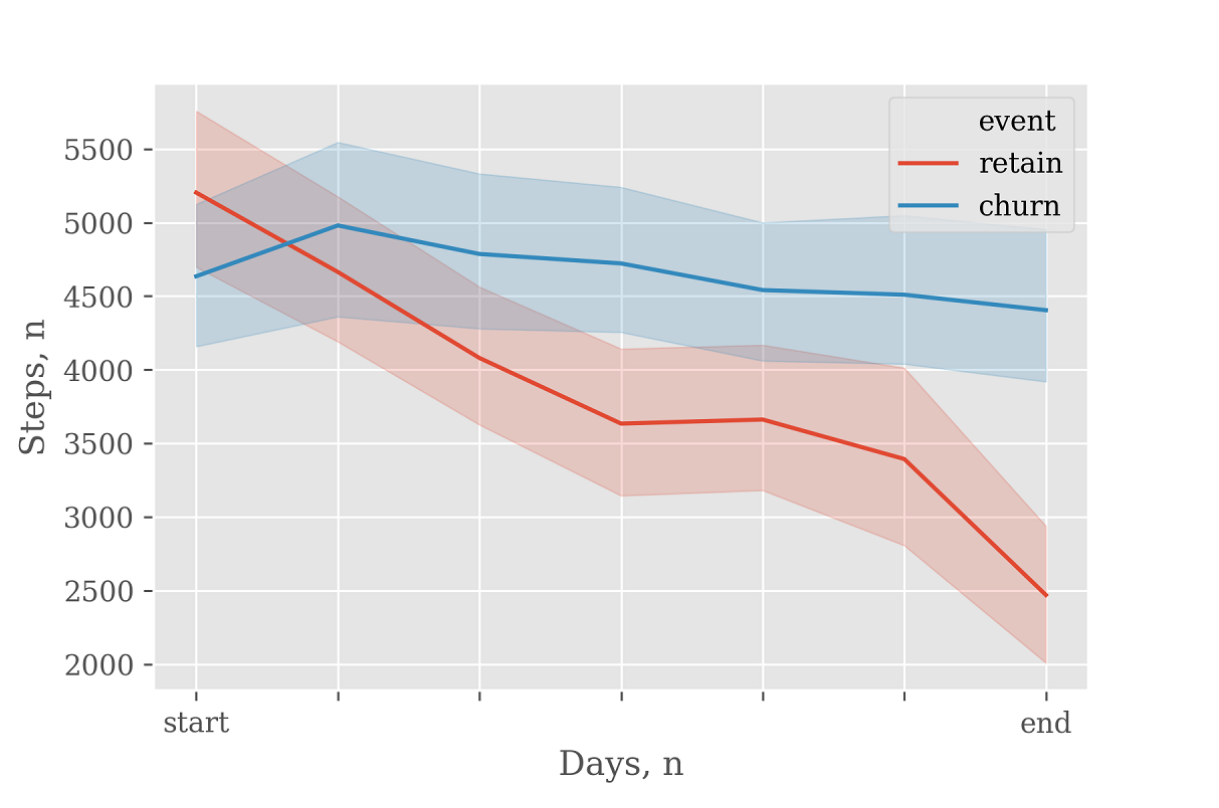
Figure 6. Changes in the mean number of steps_per_day from start to